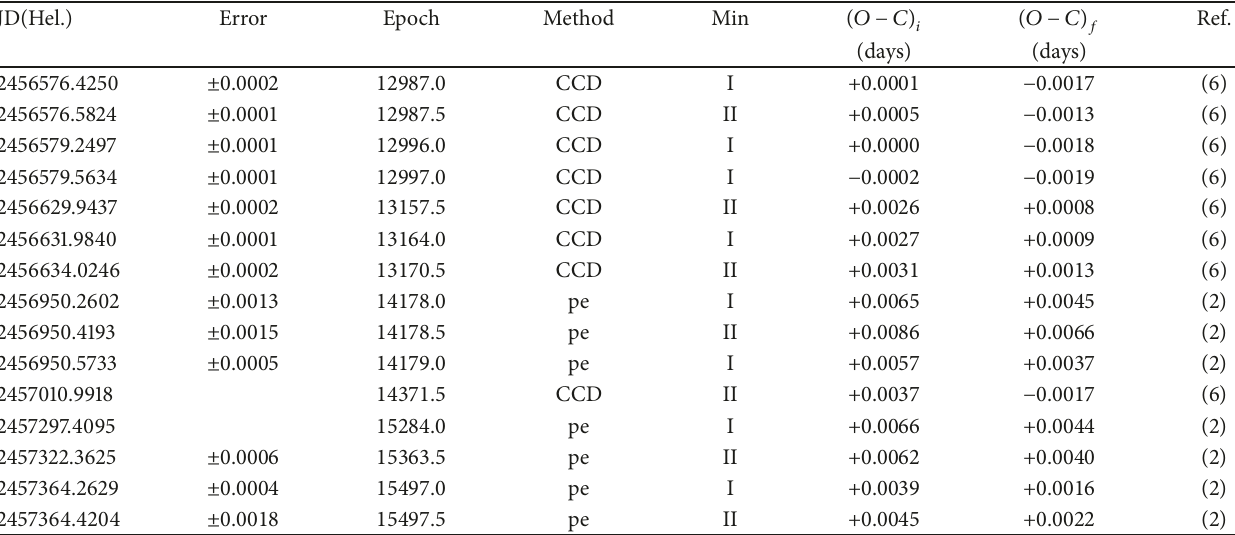
(i.e., contact one). For several fixed inclinations from 70 ∘ to 90 ∘ with a step of 5 ∘ , we first performed a series of solutions. Five computed curves for 𝑞 − 𝑖 are shown in Figure 6(a), 2 in which a minimum squared residual, Σ(𝑜 − 𝑐) 𝑖 , occurs around 𝑞 = 2.4 and 𝑖 = 85 ∘ . As a free parameter for the orbital inclination, we obtained the relations of 𝑞 − Σ and 𝑞 − 𝑓 (the fill-out factor for contact binary is defined by 𝑓 = (Ω − Ω)/(Ω − Ω ) , in which Ω Ω 𝑖𝑛 𝑖𝑛 𝑜𝑢𝑡 𝑖𝑛 and 𝑜𝑢𝑡